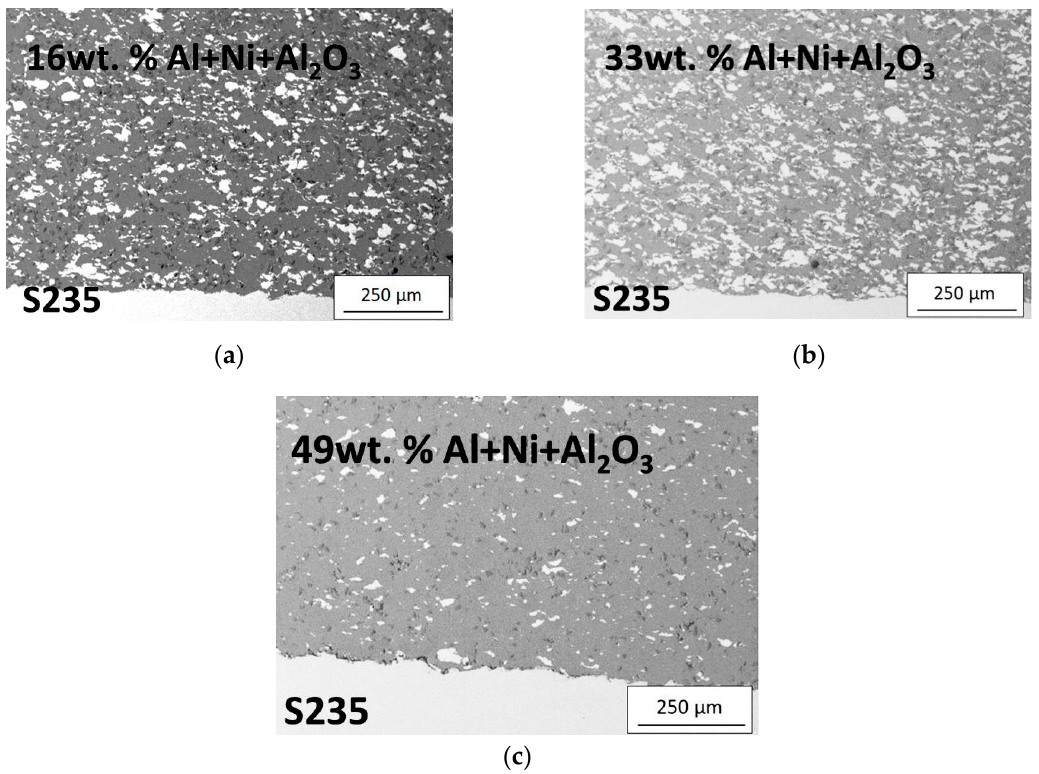
Figure 3. As-sprayed coatings (SEM, BSE) of Al+Ni+Al 2 O 3 with 16 wt.% of Al ( a ), 33 wt.% of Al ( b ), 49 wt.% of Al ( c ). Table 3. Composition of feedstock powders and corresponding coatings.